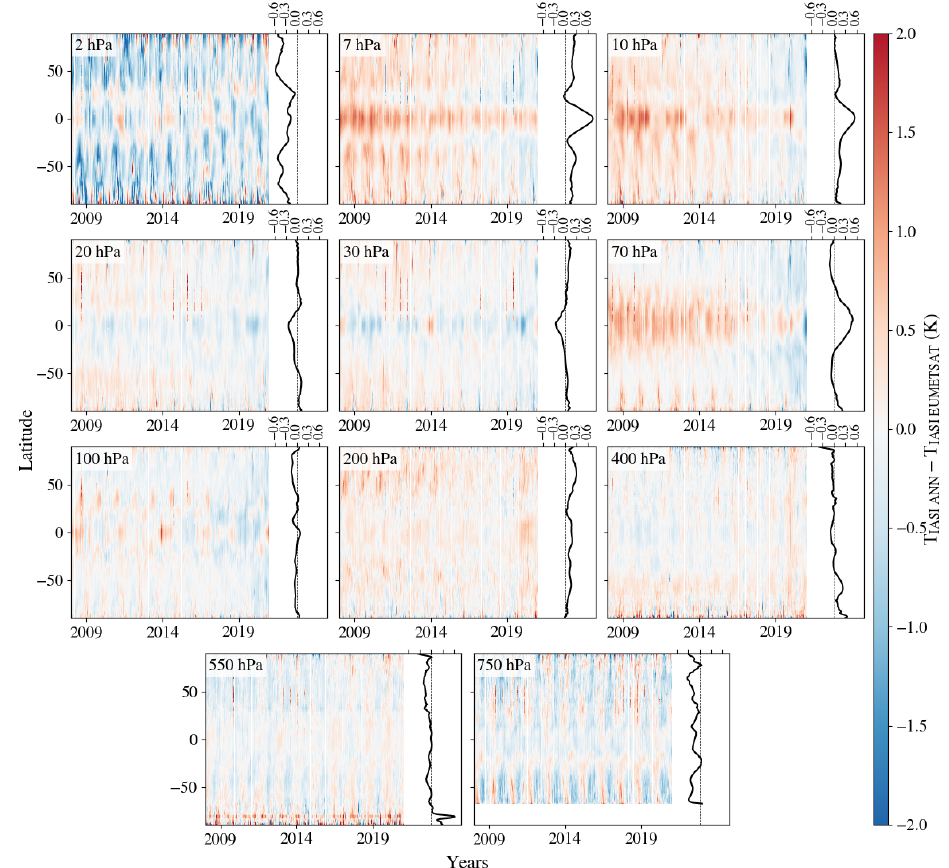
Figure 9. Daily zonal mean differences between IASI-ANN output and IASI EUMETSAT zonal mean temperature for the 11 pressure levels of the ANN. The red stripes seen in some panels are artefacts from the analysis, and they do not reflect a physical phenomenon.